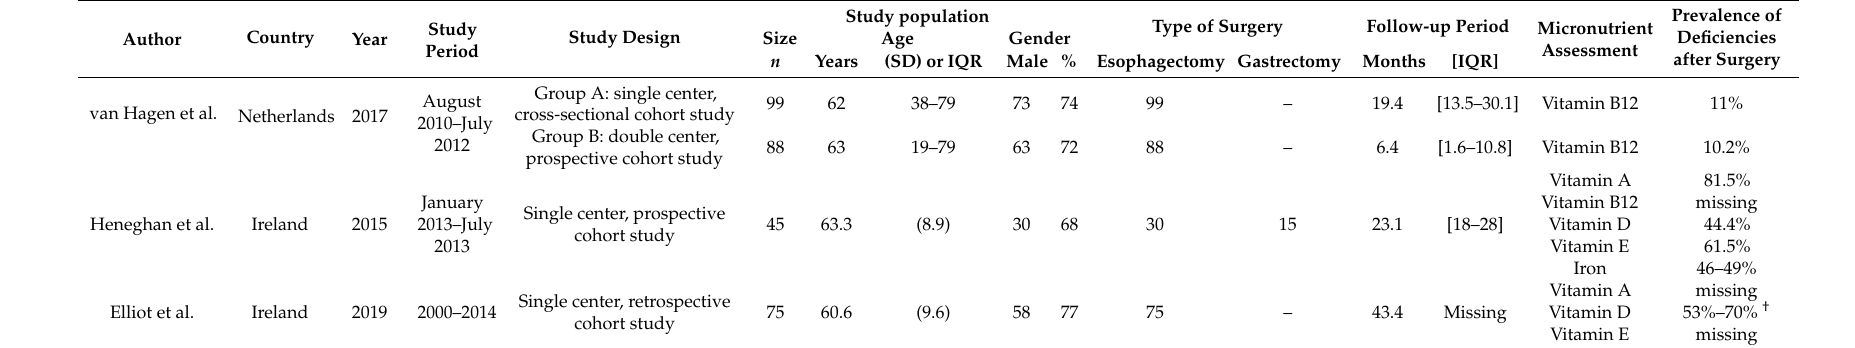
Table 1. Overview of the current literature on micronutrient deficiencies following